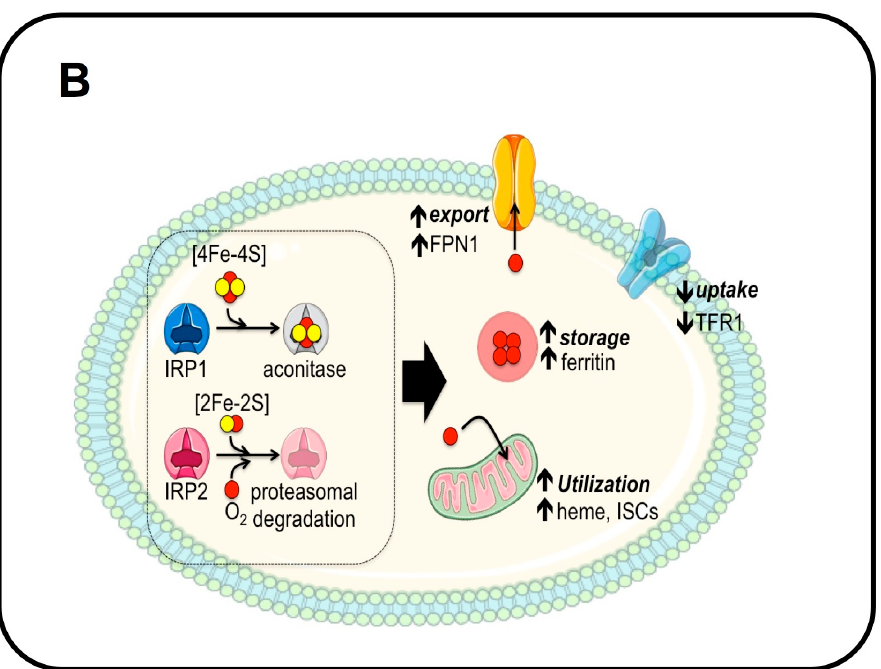
Figure 2. Mechanism of cellular iron homeostasis by the IRP/IRE system. ( A ) In conditions of decreased intracellular iron concentration, iron regulatory proteins 1 and 2 (IRP1 and IRP2) function as RNA-binding proteins and reduce the translation of ferritin and ferroportin (FPN1) and decrease mitochondrial iron utilization by binding the Iron-Responsive Element (IRE) in the 5 ′ UTR. Conversely, IRP1 and 2 increase iron uptake by binding the IRE in the 3 ′ UTR of TFR1 and DMT1. ( B ) When intracellular iron levels increase, IRP1 binding to iron–sulfur clusters (ISCs) converts the RNA-binding protein into aconitase, whereas IRP2 is degraded by the proteasome via a mechanism dependent on iron, ISC, and oxygen levels. Thus, ferritin and FPN1 are translated to favor iron storage and export, and the utilization of iron by the mitochondria is increased. Conversely, TFR1 and DMT1 mRNAs are reduced. Panels A and B: adapted with permission from Ref. [6]. License date: 15 February 2023; Elsevier.